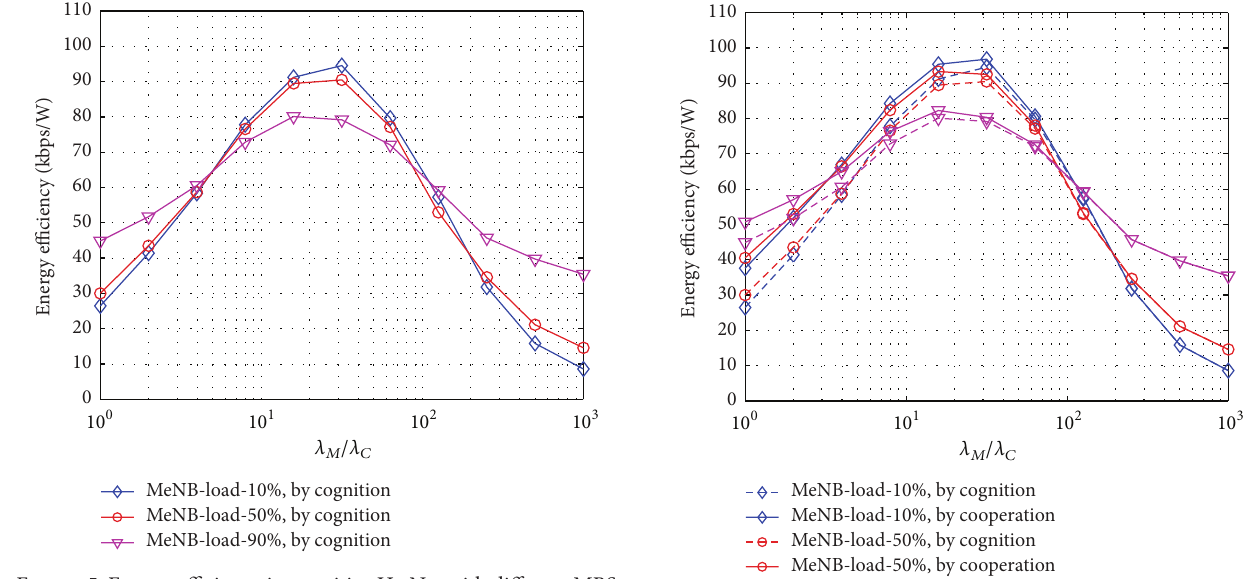
Figure 5: Energy efficiency in cognitive HetNet with different MBS load.